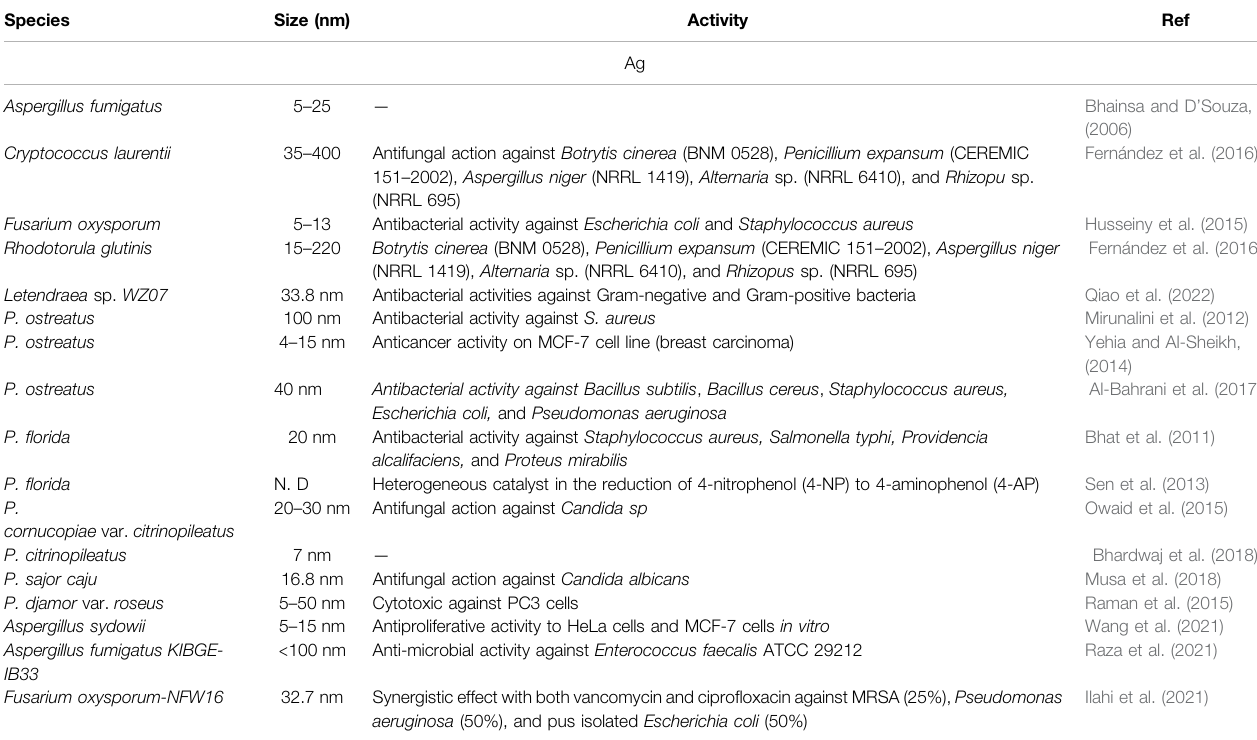
TABLE 2 | Reported representation of fungus synthesizing silver nanoparticles.